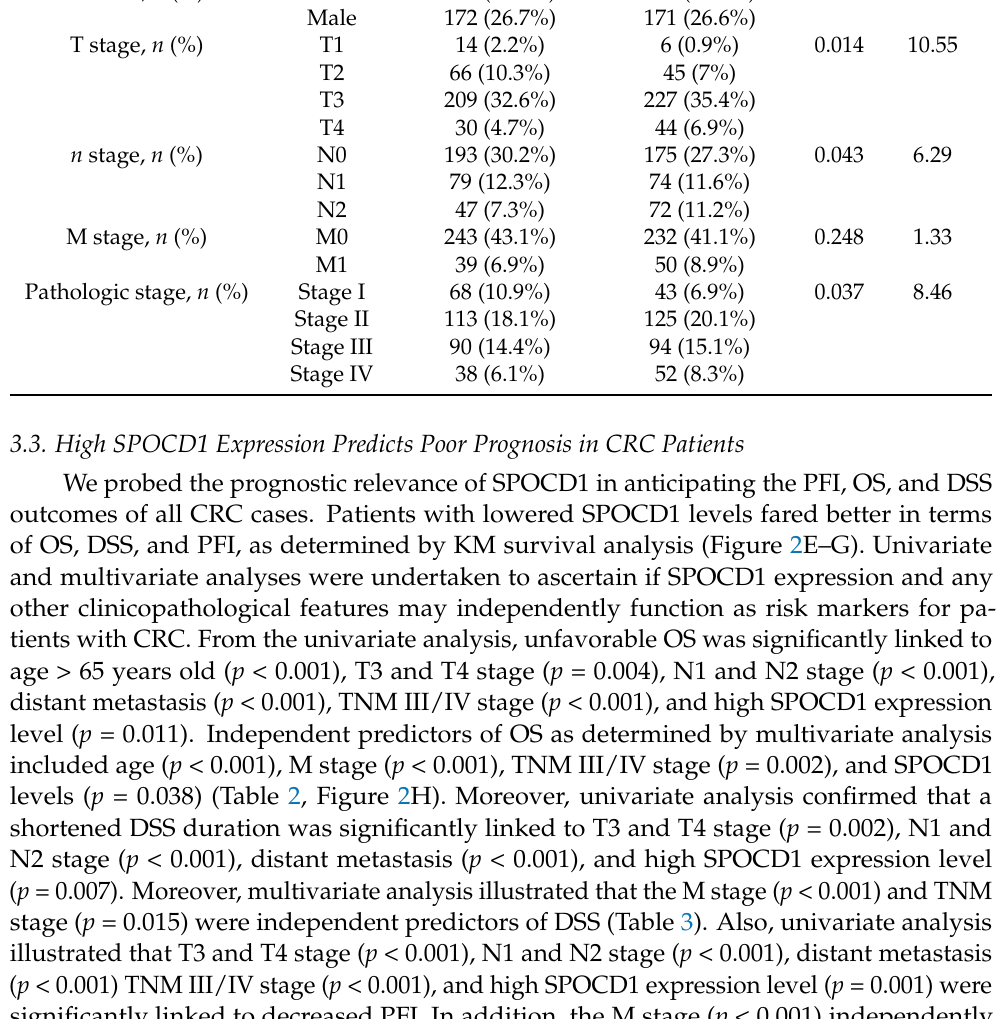
Table 1. The correlation of clinicopathological characteristics and SPOCD1 expression. SPOCD1 p Statistic Characteristic Levels Low Expression High Expression n 322